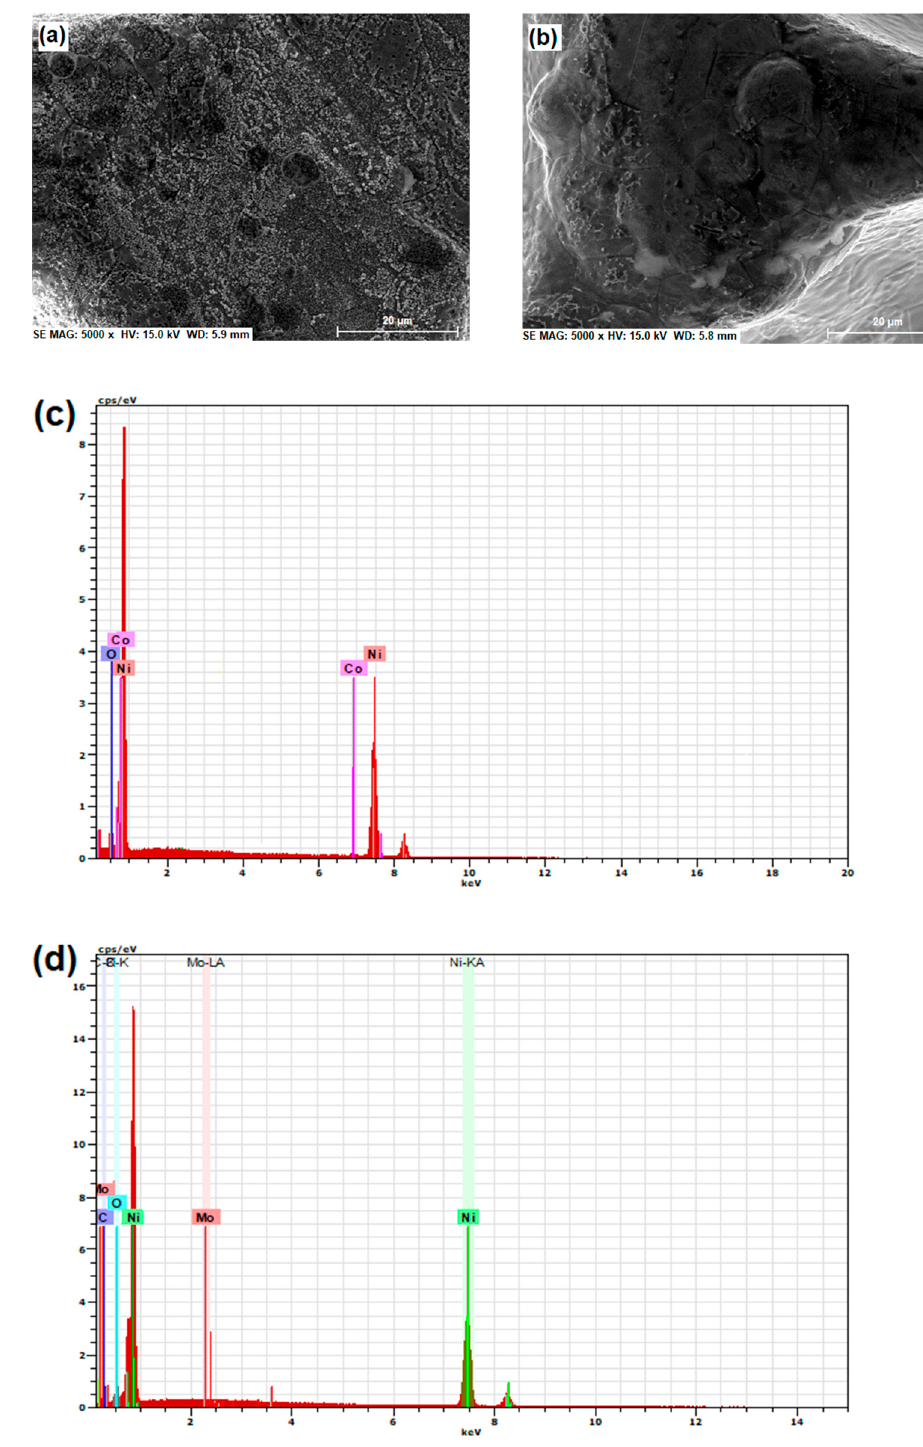
Figure 1. SEM micrograph pictures of Co-modified Ni foam surface ( a ), and Mo-activated Ni foam surface ( b ), taken at 5000 × magnification with EDX pattern of Co- ( c ) and Mo-activated ( d ) Ni foam samples.